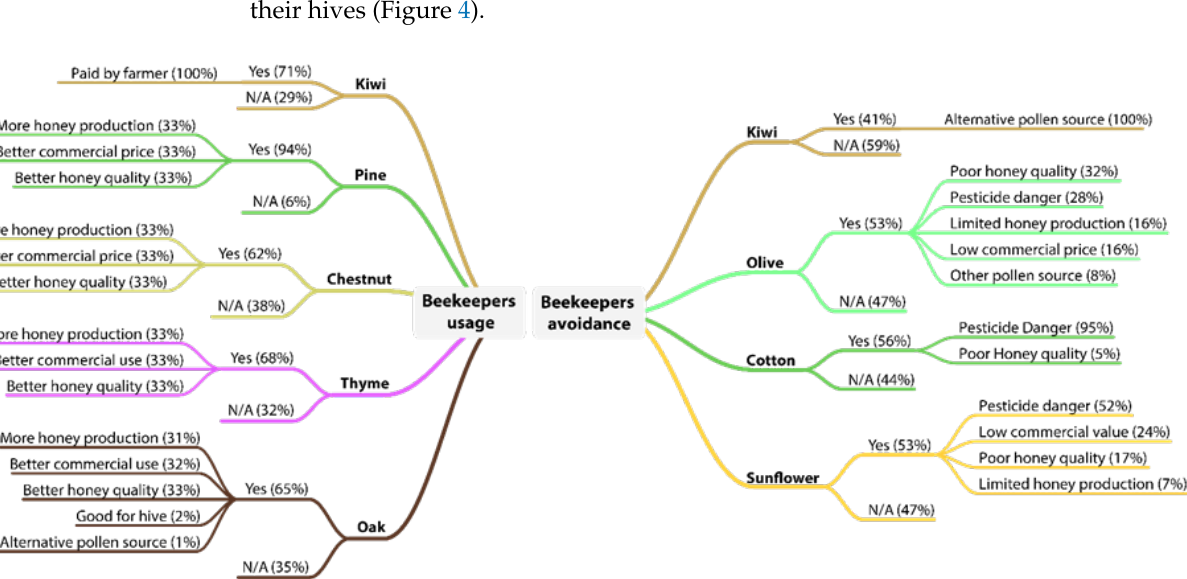
Figure 3. Summary of the main crops used (blue) and avoided (black) by beekeepers.